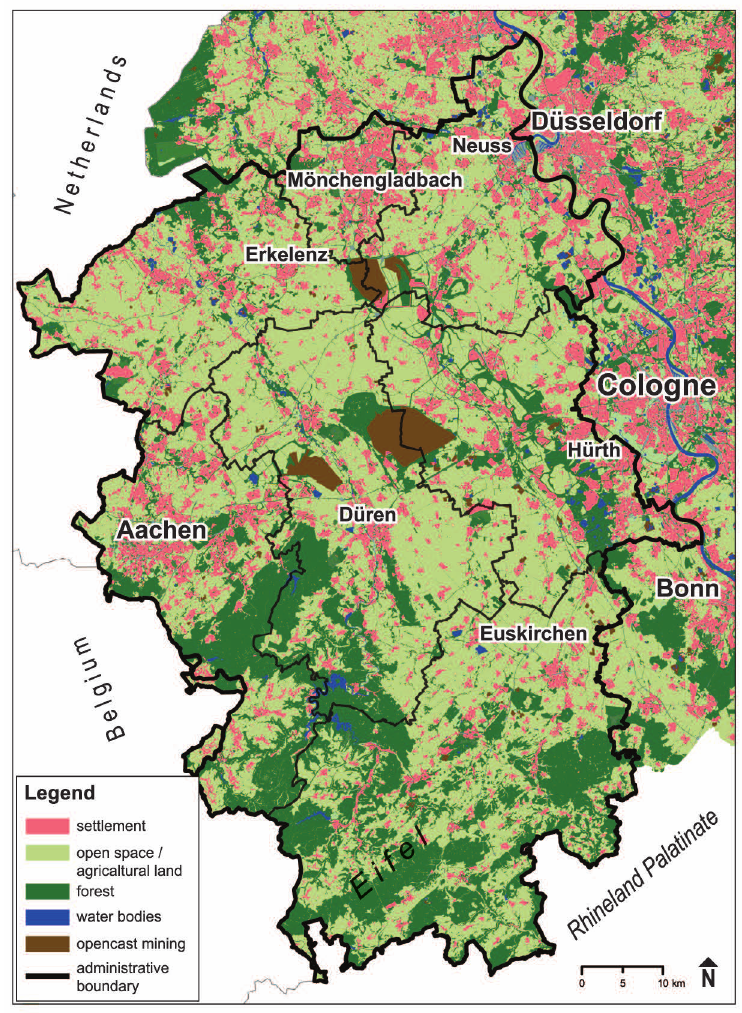
Figure 1. Overview of the Rhenish lignite mining region and its land use. Own figure based on data licence Germany—Attribution—Version